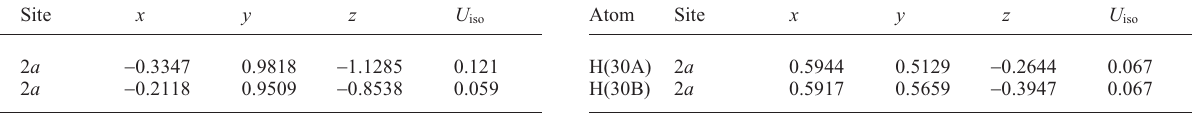
Table 3. Atomic coordinates and displacement parameters (in Å 2 )